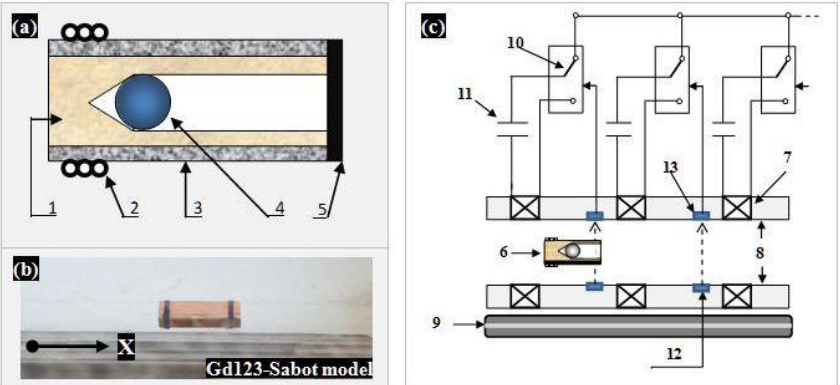
Figure 5. Multiple-stages accelerator for noncontact target transport: ( a ): HTSC-Sabot, which includes 1—polymer matrix, 2—HTSC-coils (MgB 2 -driving body), 3—HTSC-plates, 4—target, 5—shield or cover to protect the injected target from a head wind of a residual gas in the reaction chamber; (b) :